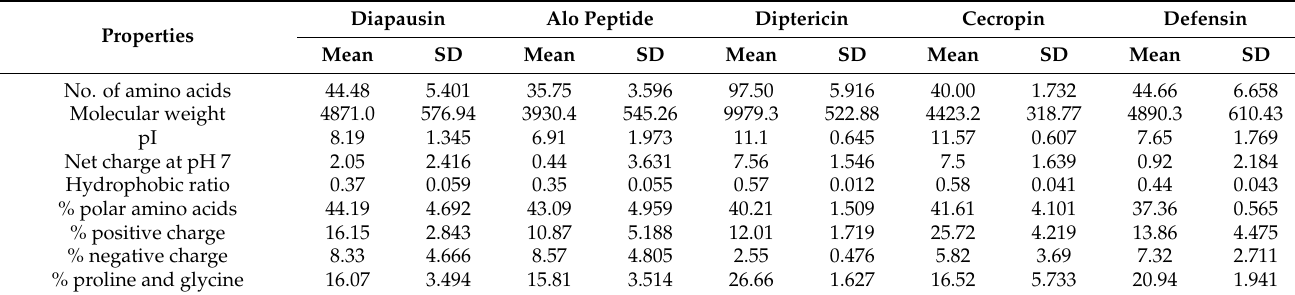
Table 2. Physicochemical properties of the mature sequence of collembola AMPs by families. Full details for each AMP are reported in Supplementary Table